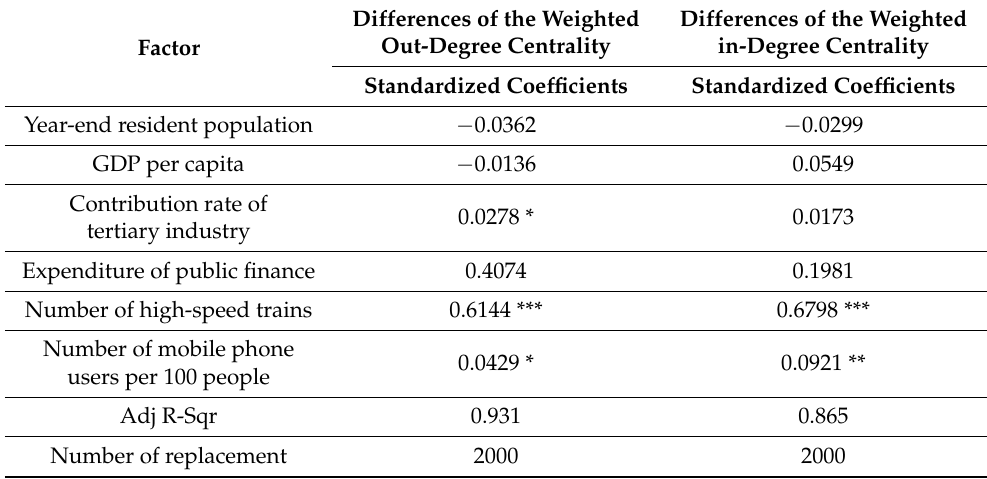
Table 1. Results of QAP regression